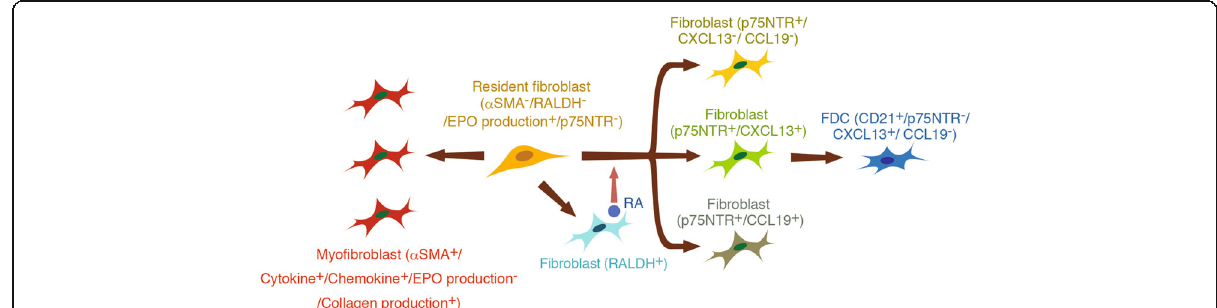
Fig. 3 Fibroblasts have two jobs during CKD: fibrosis and inflammation. Resident fibroblasts critically contribute to fibrosis and the persistence of inflammation in the injured kidney [3]. Upon injury, resident fibroblasts transdifferentiate into myofibroblasts, which produce a large amount of ECM protein and pro-inflammatory cytokines/chemokines, at the cost of EPO production. Moreover, in the aging milieu, resident fibroblasts also transdifferentiate into several distinct phenotypic fibroblasts, which orchestrate TLT formation. In response to injury, resident fibroblasts differentiate into RALDH-positive fibroblasts, which induce transdifferentiation of other fibroblasts into p75NTR-positive fibroblasts with three phenotypes, which include CXCL13- and CCL19-producing fibroblasts. In the later phase of TLT formation, some of these p75NTR-positive fibroblasts lose this expression and mature into CD21/CXCL13-positive